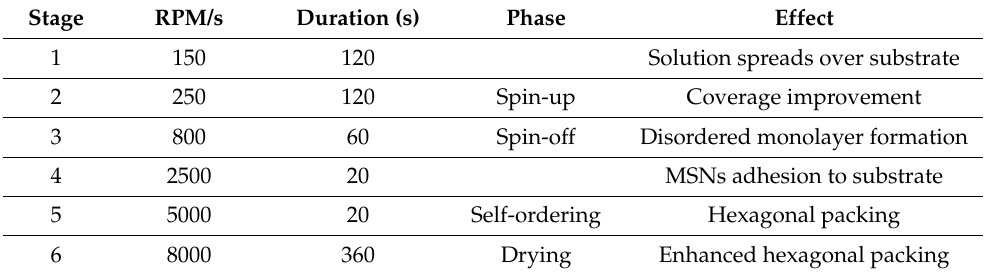
Table 1. Spin coating routine